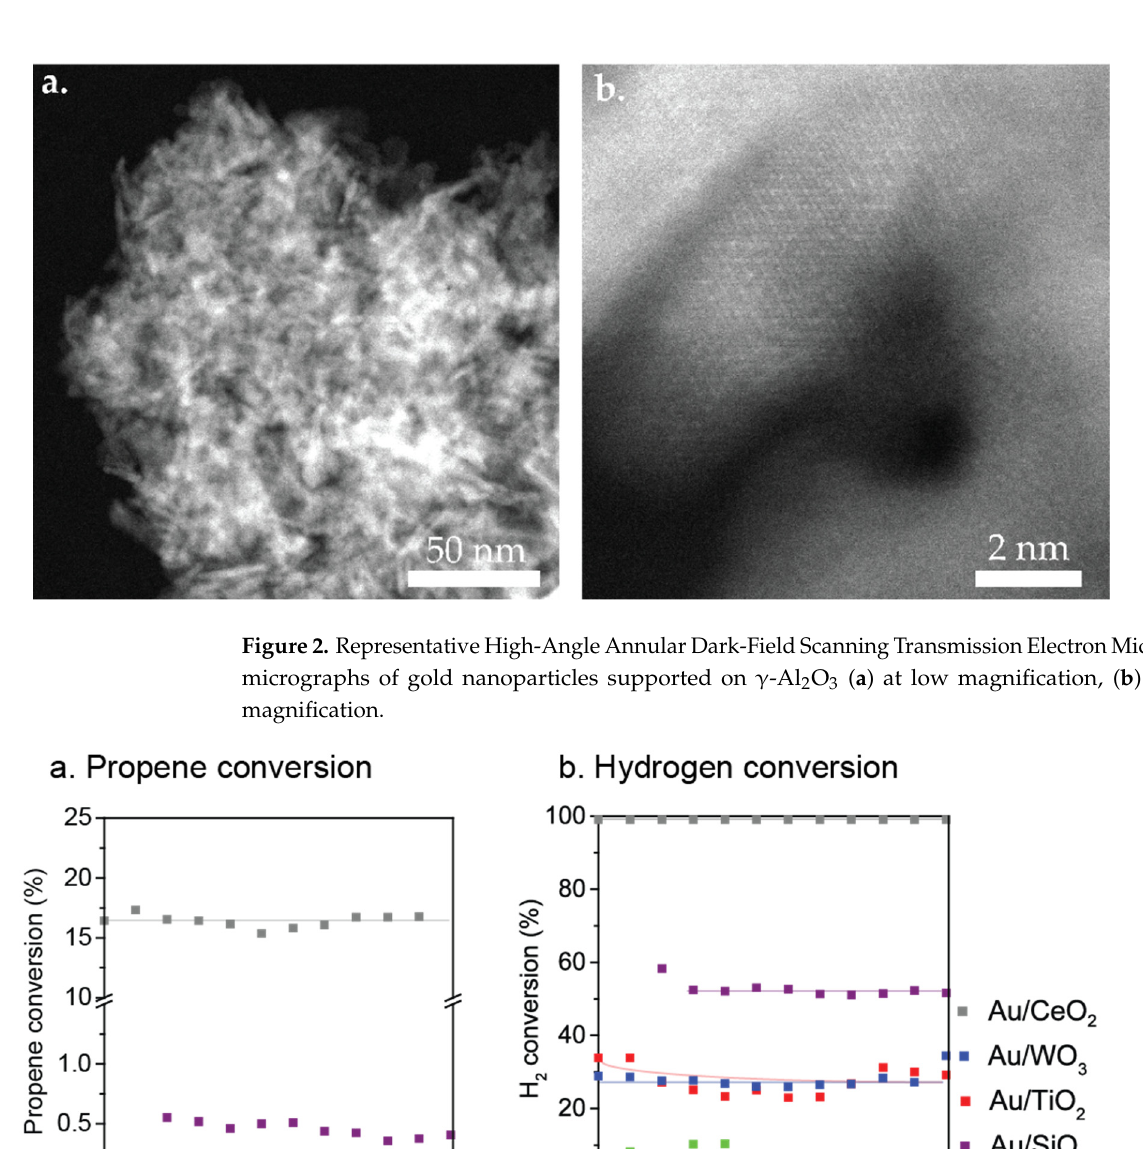
Figure 1 . Representative High-Angle Annular Dark-Field Scanning Transmission Electron Micros- copy micrographs of gold nanoparticles supported on oxidic supports. ( a ) Au/CeO 2 , ( b ) Au/WO 3 , ( c ) Au/TiO 2 , ( d ) Au/SiO 2 .